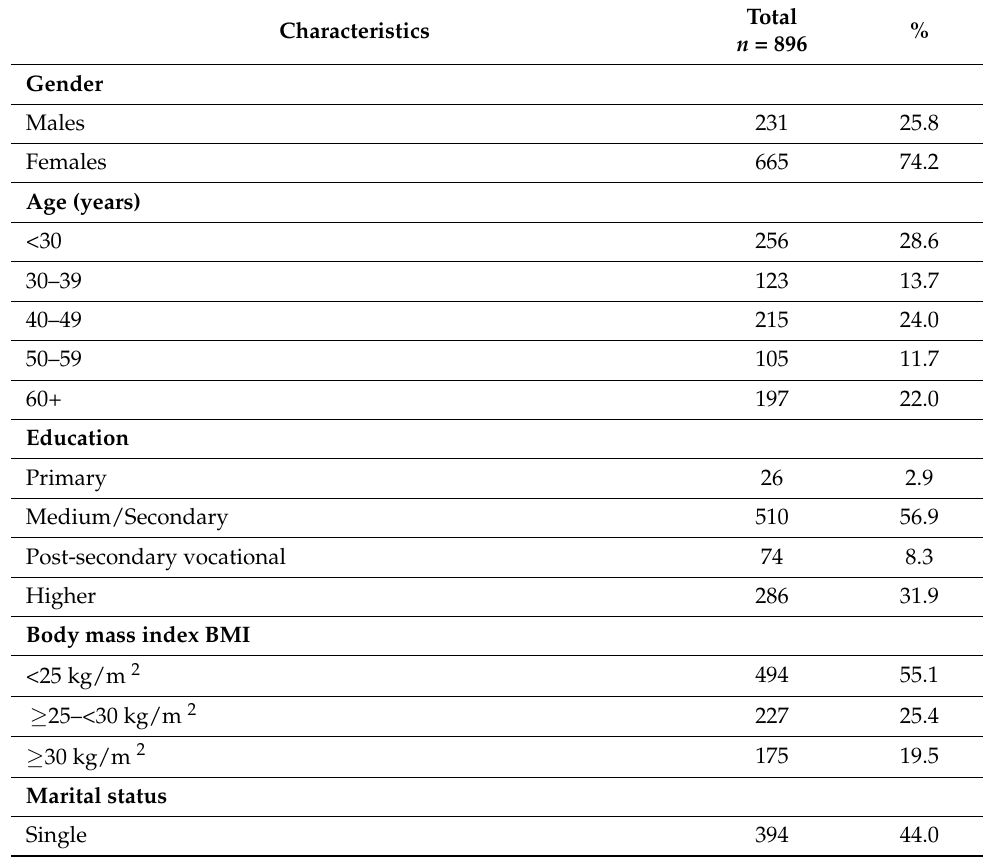
Table 1. Characteristics of the studied